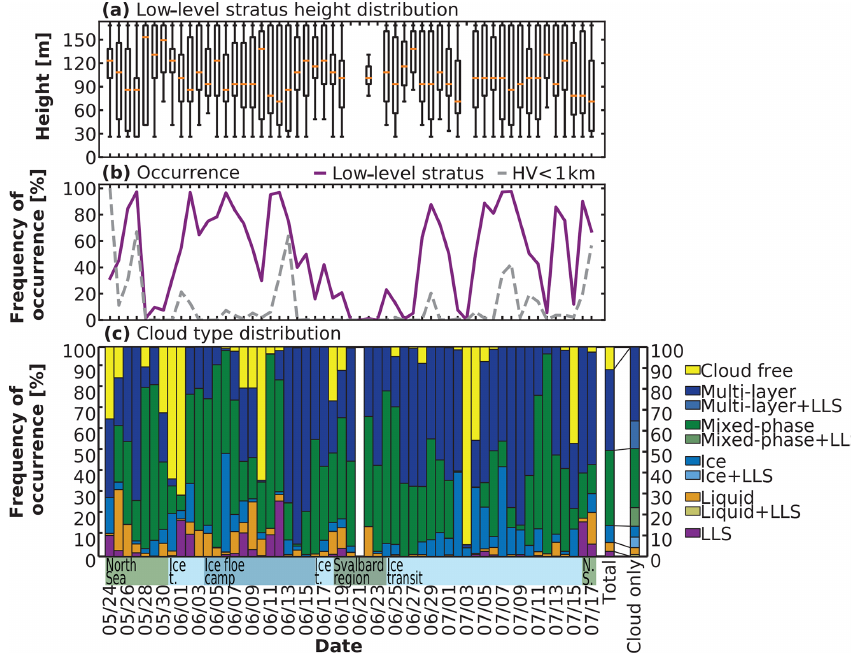
Figure 18. (a) Daily height distribution of the detected low-level stratus during PS106 up to 165m. (b) Daily fraction of low-level stra- tus occurrence derived by Polly XT measurements (purple) in comparison to horizontal visibility (HV) below 1km (grey). (c) Cloud type statistics including low-level stratus clouds during PS106, determined by Cloudnet. Purple indicates the fraction when low-level stratus was determined, while orange indicates liquid clouds, light blue ice clouds, green mixed-phase clouds, dark blue multi-layer clouds, and yellow cloud-free periods. Each column except the last two represents a day of the campaign. The penultimate column represents the total distribution of the different cloud types. The last column distinguishes between the respective cloud type without low-level stratus detected (same color as in the other column) and with an additional low-level stratus detected below (slightly varied color). At the bottom, a rough localization of Polarstern is annotated – green: North Sea (N.S.); light blue: ice transit (Ice t.); dark blue: ice floe; camp; dark green: Svalbard region.